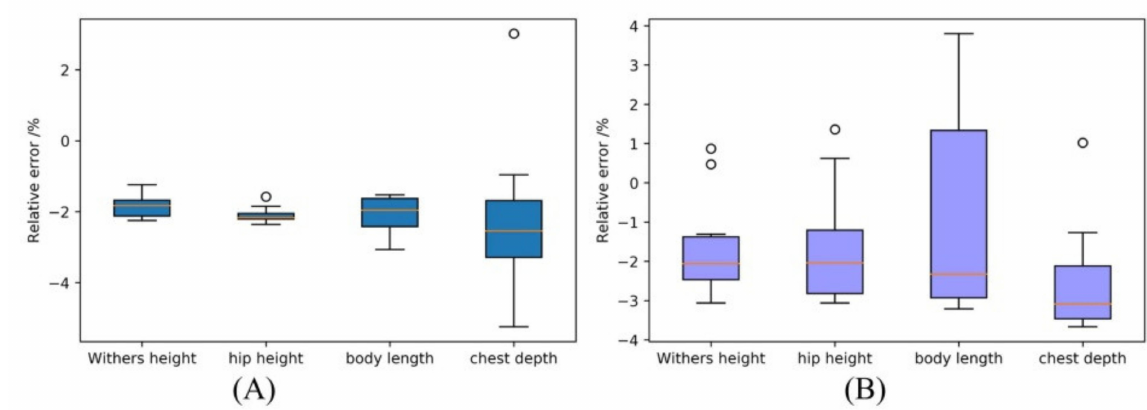
Figure 18. Box plots of relative error: ( A ) Box plots of the relative error the measurement of the cattle body size; ( B ) Box plots of the relative error the measurement of the goat body